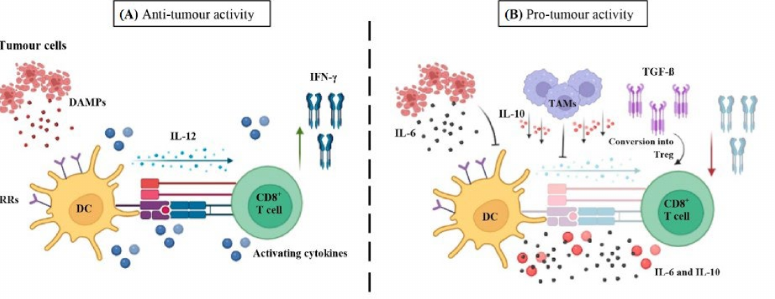
Figure 3. Anti- and pro-tumour microenvironment of DCs and CD8 + T cells. ( A ) Antitumour mi- croenvironment: Antigen presentation by DCs via MHC-I to CD8 + T cells is depicted. For T